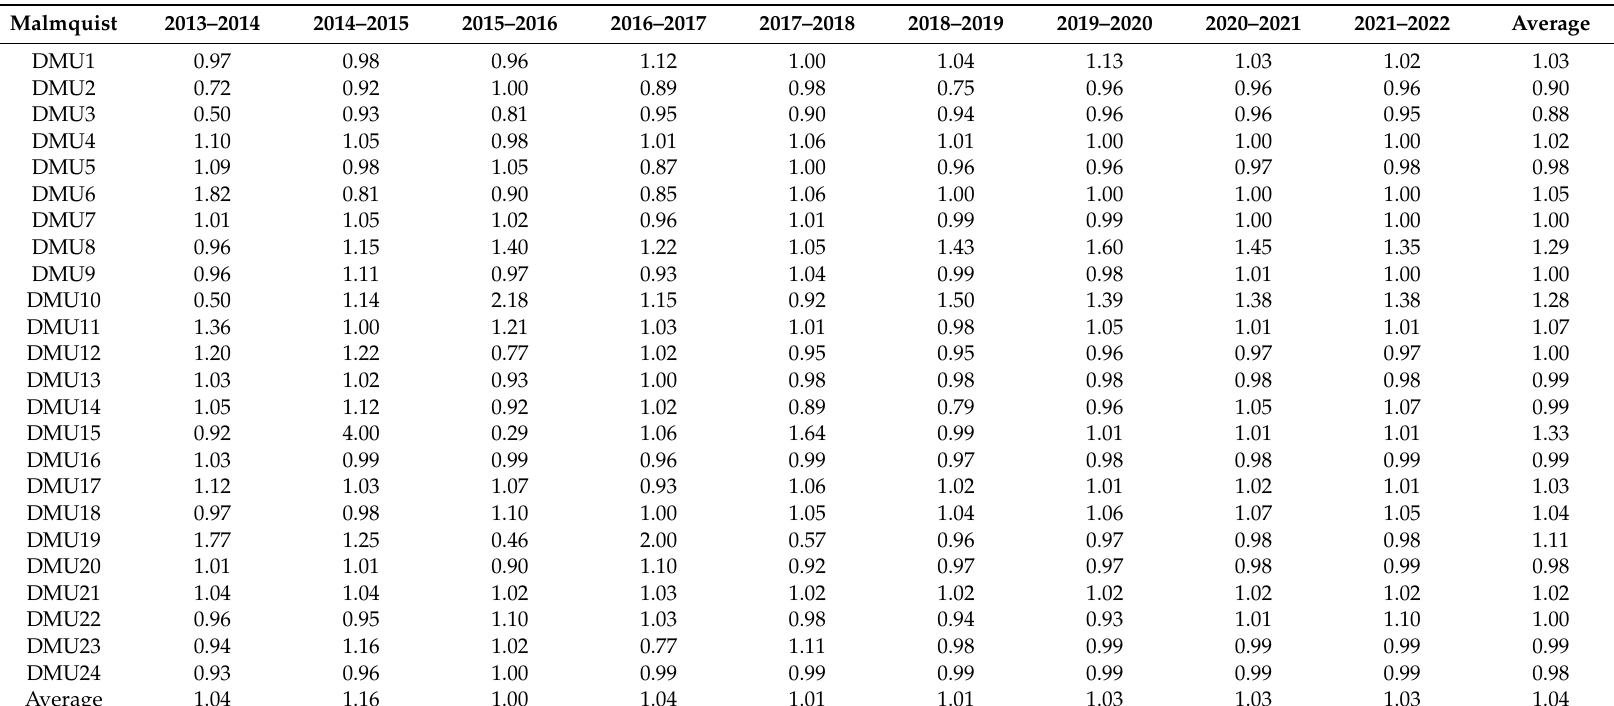
Table 8. The Total productivity